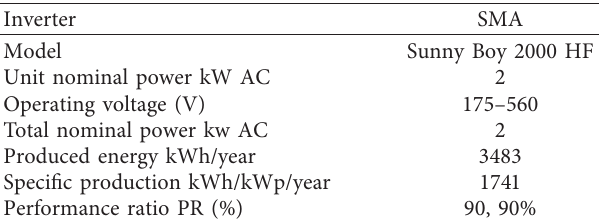
Figure 6: The energy distribution from the inverter, which depends on PV array voltage and current; in this case, the operating voltage of the inverter corresponds to 175–560V. Table 4: Recaps of simulation of ENSET’s AC PV